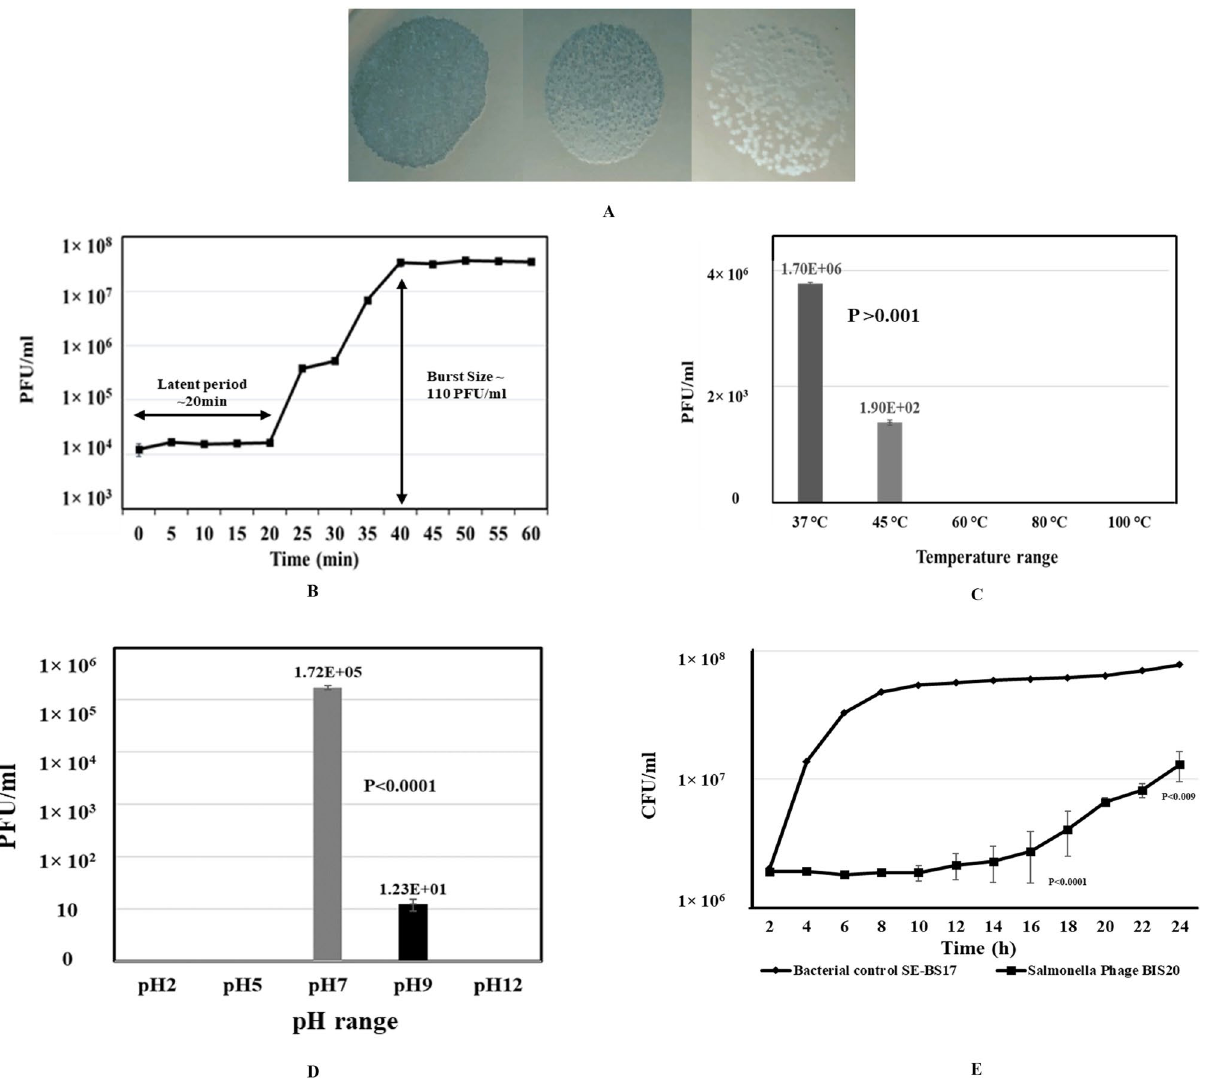
Figure 1. Physical Characterization of Salmonella phage BIS20: ( A ) BIS20 plaque morphology, turbid zones of lysis indicative of temperate nature of phage ( B ) Latent period and burst size of BIS20 determined by one step growth curve method ( C ) Temperature stability of BIS20; Phage was stable at 37 °C, barely survived at 45 °C, no plaques were observed at other temperatures tested. ( D ) BIS20 pH stability between 2 and 12 pH range; BIS20 grew best at pH7 and barely survived at pH 9 ( E ) Bacterial growth reduction assay; reading was monitored for 24 h, control; Salmonella Typhimurium (SE-BS17) in LB; SE-BS17 bacterial culture infected with Salmonella phage BIS20 at MOI1. All values are represented as average of